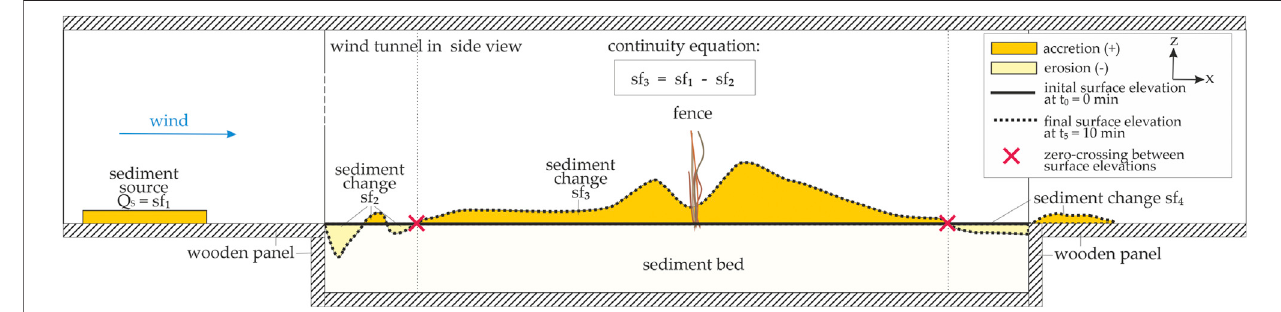
FIGURE 6 | Two-dimensional side view of the wind tunnel test section showing the different sediment fl uxes schematically: sf 1 – sf 4 for determining the trapped sediment, see Eq. 13 .